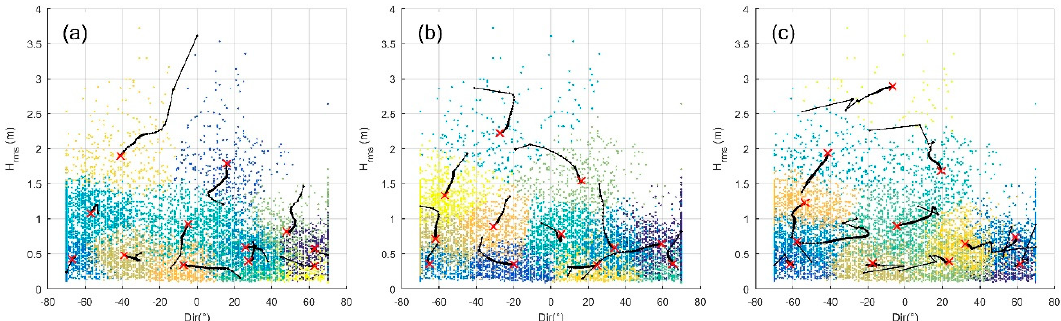
Figure 4. Examples of a selection of Crisp k-means ( a ), Fuzzy k-means ( b ), and K-harmonic ( c ) methods with 12 representative wave conditions. The red crosses are the representative wave conditions, and the small dots are the wave data. The colors indicate the clusters. The black lines represent the path followed by the centroids during the iterative process.